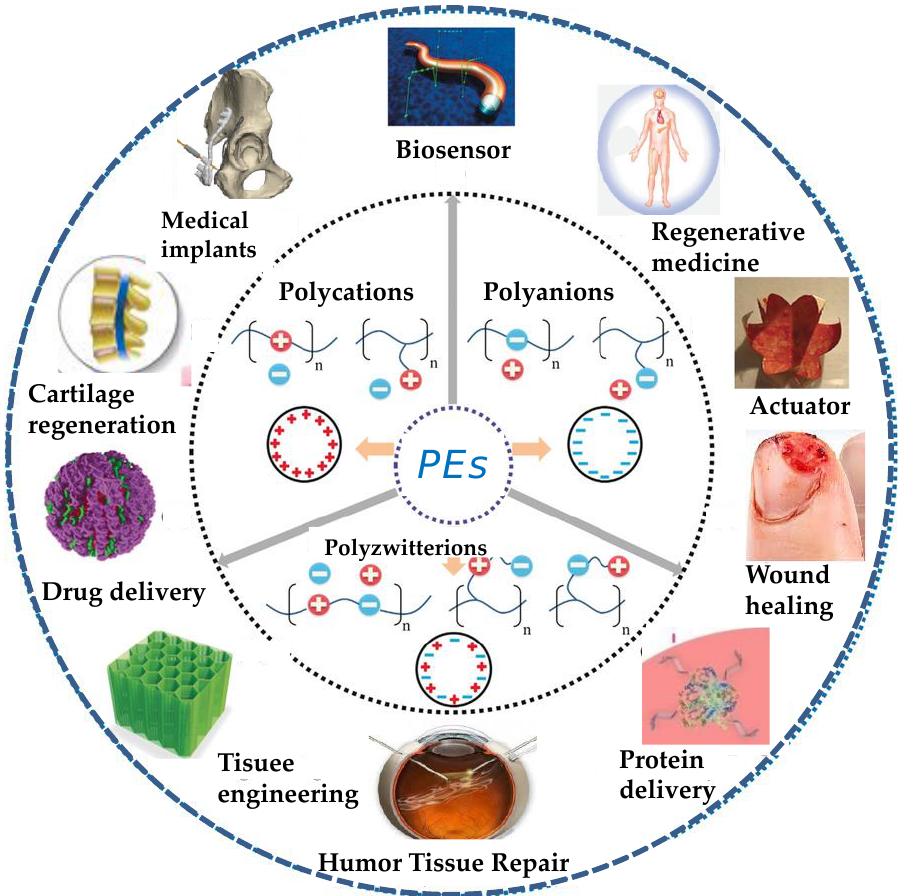
Figure 1. Schematic representation of the biomedical applications of PEs. Depending on their shape, PEs are classified into spherical and rigid rod PEs. For instance, globular proteins are spherical, while poly(p-phenylene) is rigid rod-shaped. Besides, based on their architecture, that is, the location of ionic sites, they are named as linear, branched, and crosslinked PEs. Different branched structures are stars (regular and irregular), comb-like, H-shaped, and dendrimers. According to their composition, there are two main types: homopolymers, prepared by crosslinking only one type of monomer, and copolymers by crosslinking more than one type of monomer [5].